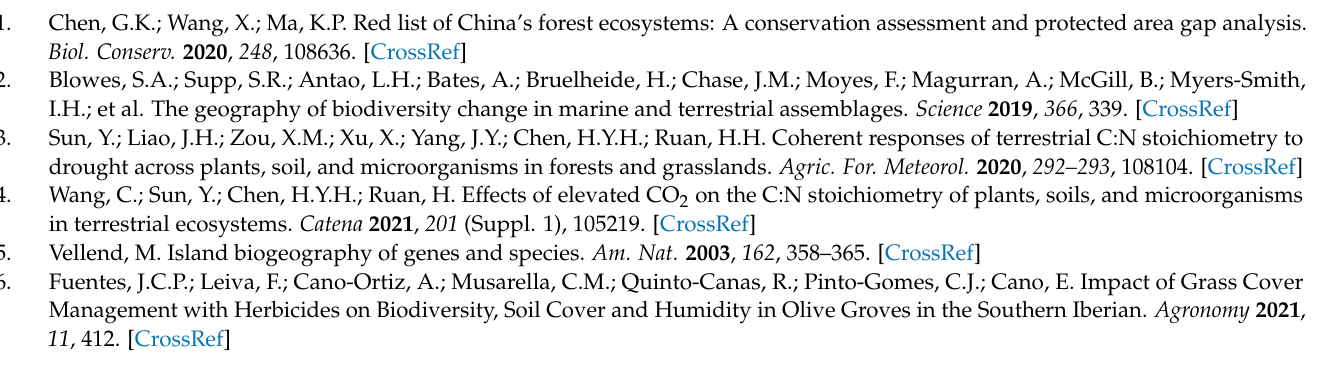
publications; Figure S2: The 295 effect sizes estimate for SGDC; Figure S3: Funnel plot used to determine publication bias; Figure S4: The 61 effect sizes estimate for β -SGDC; Table S1: Information for 40 studies; Table S2 Interaction of two categorical variables on effects of SGDC, p -value < 0.05 are shown in the